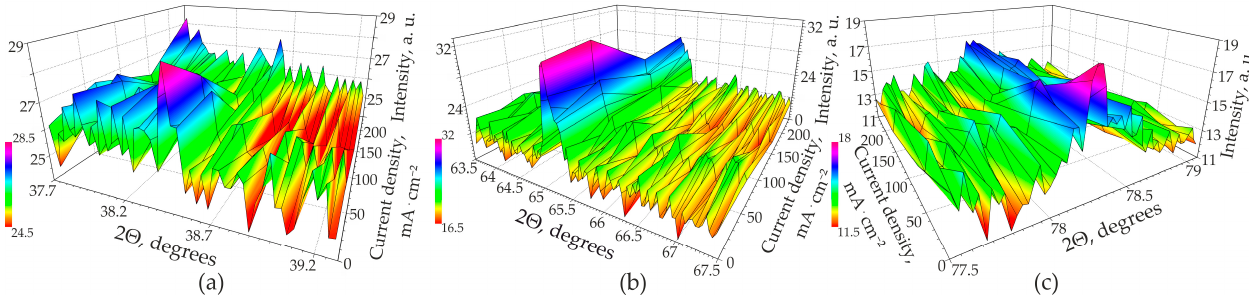
Figure 11. Dependence the XRD peak intensity of aluminum on the anodic current density during galvanostatic anodizing in pure 0.6 M MA in the 2 Θ ranges of ( a ) 37.7–39.1°, ( b ) 63.5–67.5°, and ( c ) 77.5–79.1°.